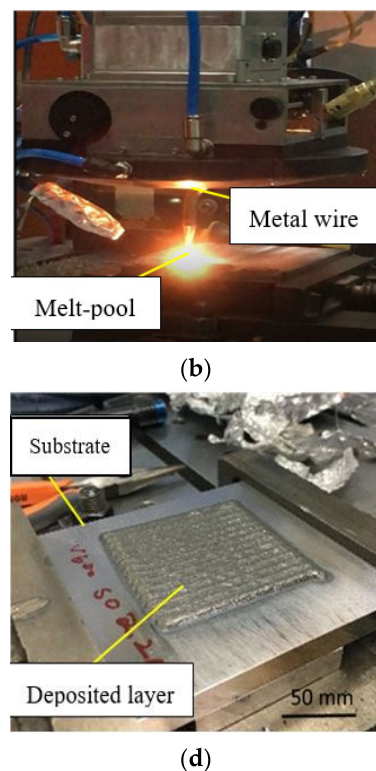
Figure 13. ( a ) Setup of the optical laser head, ( b ) laser-aided additive manufacturing (LAAM) process, ( c ) single-tracks deposited with nonoptimal process parameters, and ( d ) solid layer deposited with optimal process parameters.